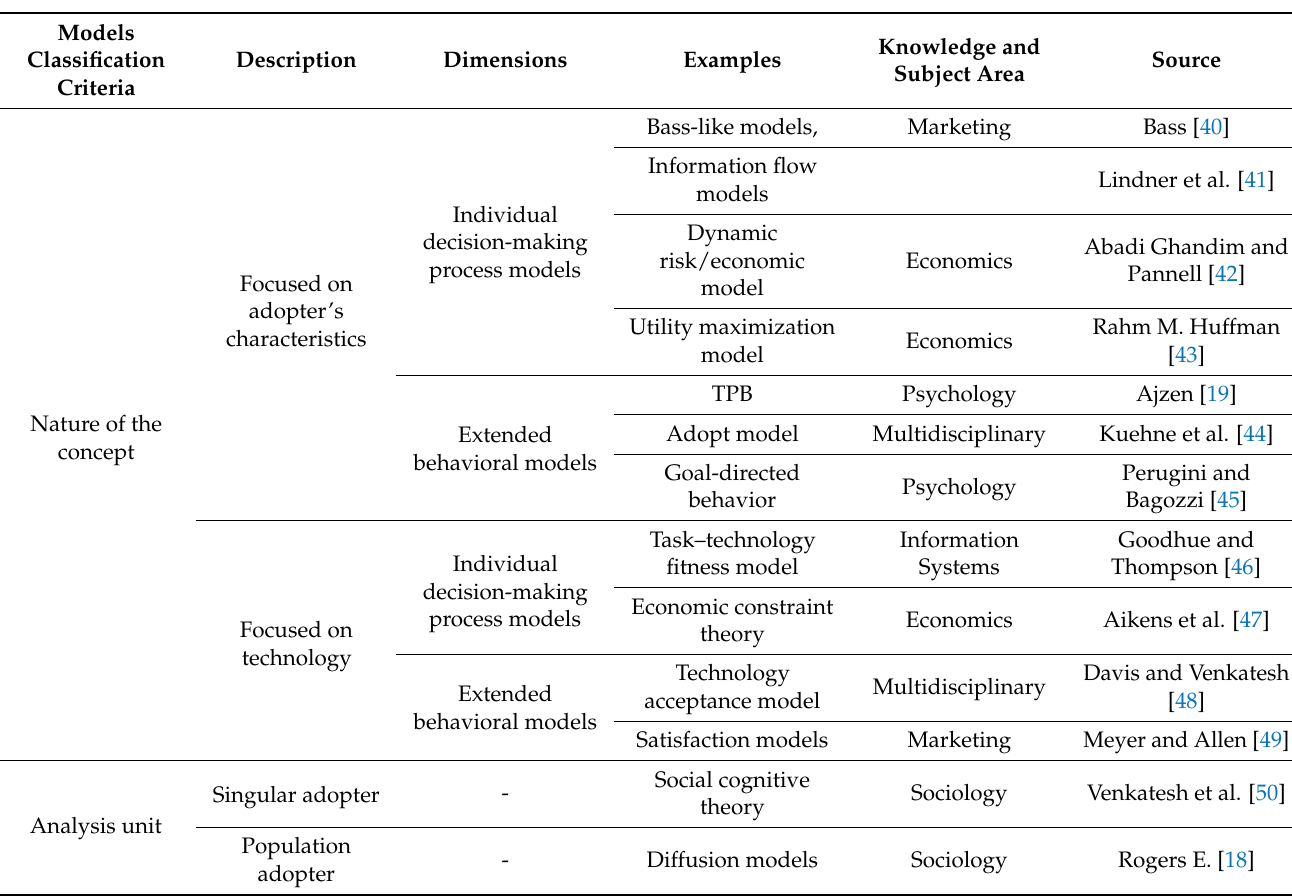
Table 1. Models explaining the agricultural innovation uptake decision process and its classification criteria (adapted with permission from Munguia et al.